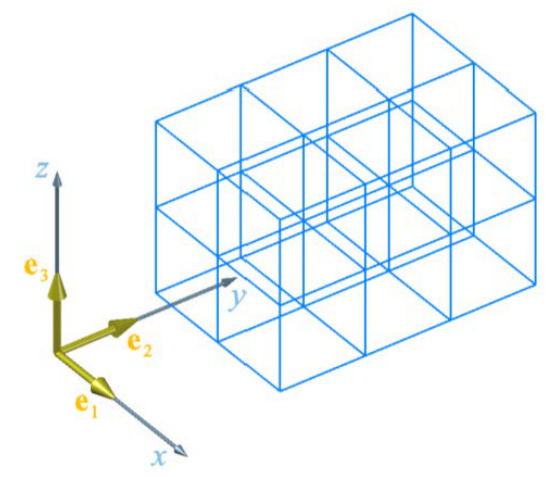
Figure 44: Cartesian cell complex in three dimensions.